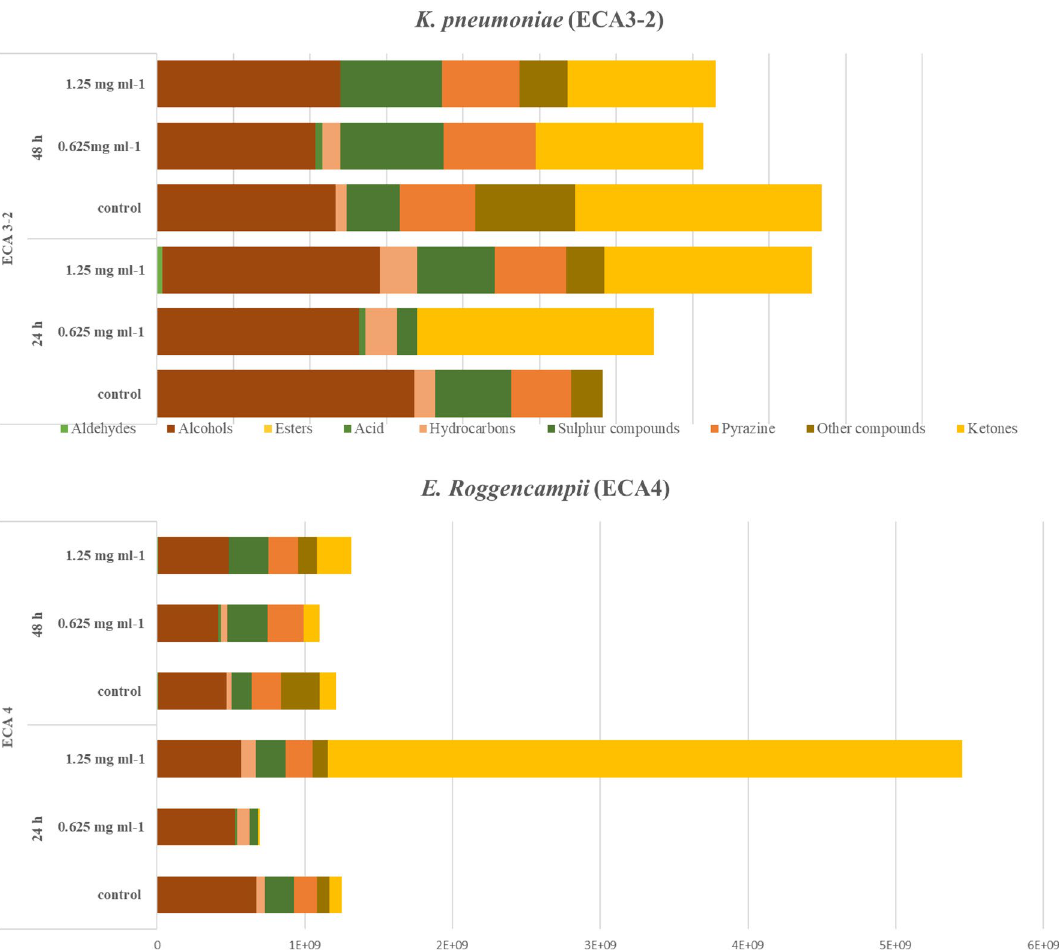
Figure 6. Volatile organic compounds (principal functional groups) produced by from K. pneumoniae (ECA3- 2) and E. roggenkampii (ECA4), after and without the addition of Arg-SUNCs at 24 and 48 h of